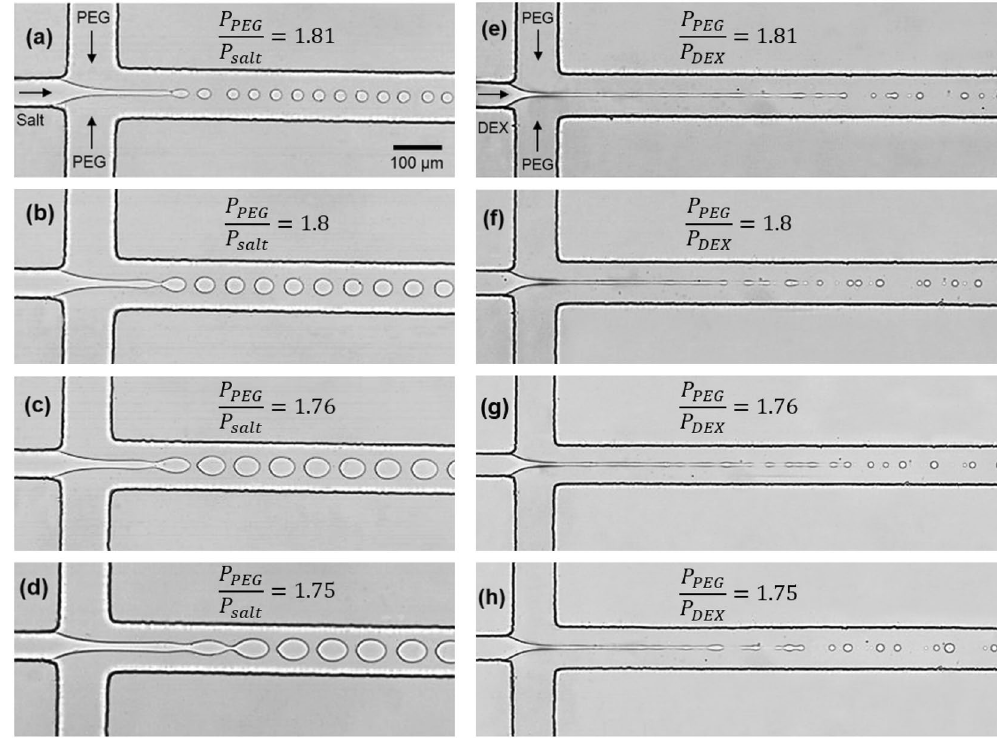
Figure 4. Experimental images of droplet generation in the ( a – d ) PEG/salt system; ( e – h ) PEG/DEX system. Droplet diameter ( D ) varies with the pressure ratio. ( a ) D = 25.5 μ m; ( b ) D = 32.9 μ m; ( c ) D = 46.2 μ m; ( d